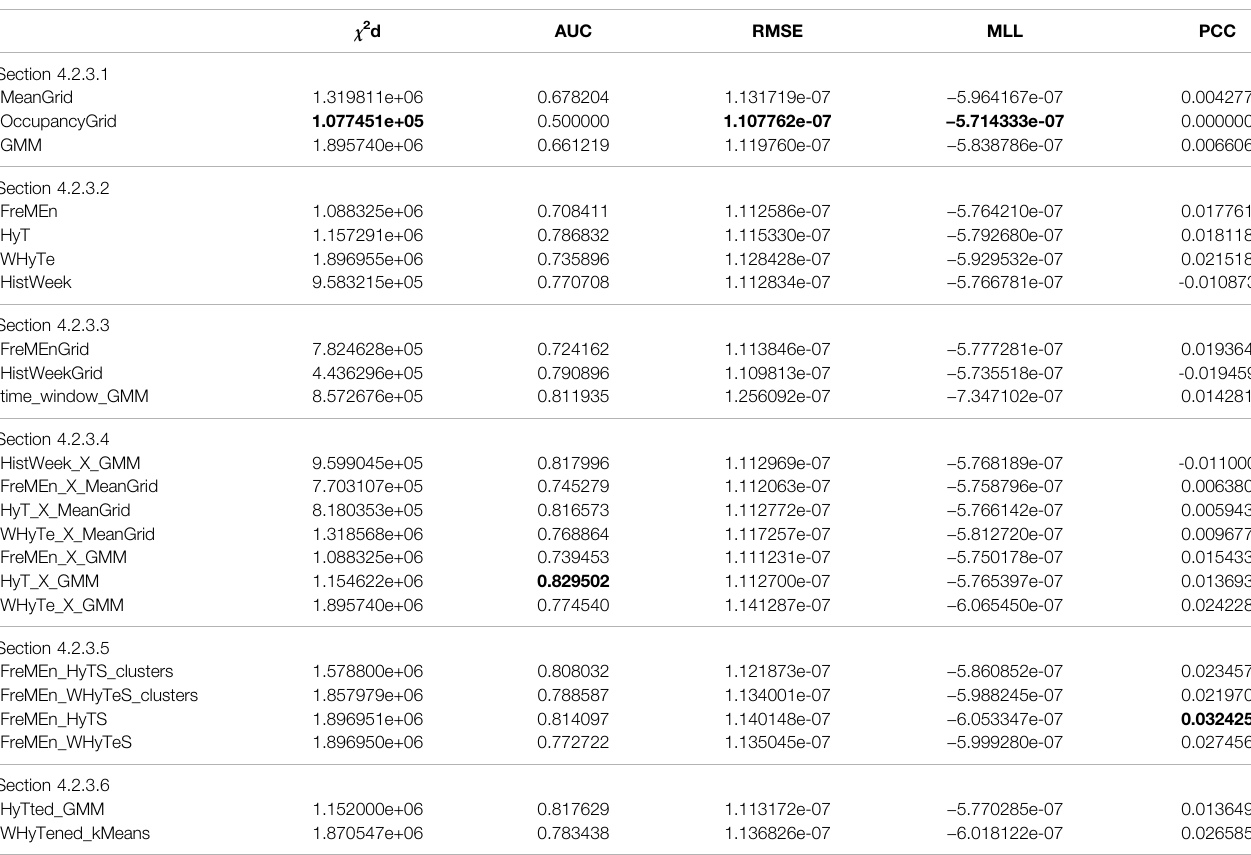
TABLE 2 | Comparison of the approaches using popular